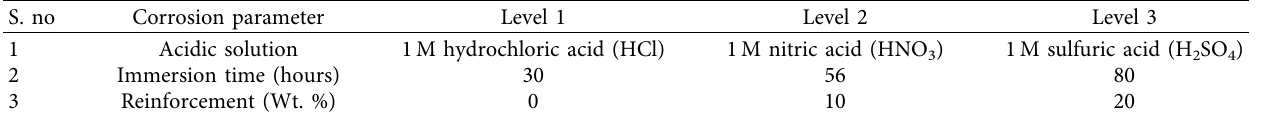
Table 1: Corrosion experiment parameters and their three levels.